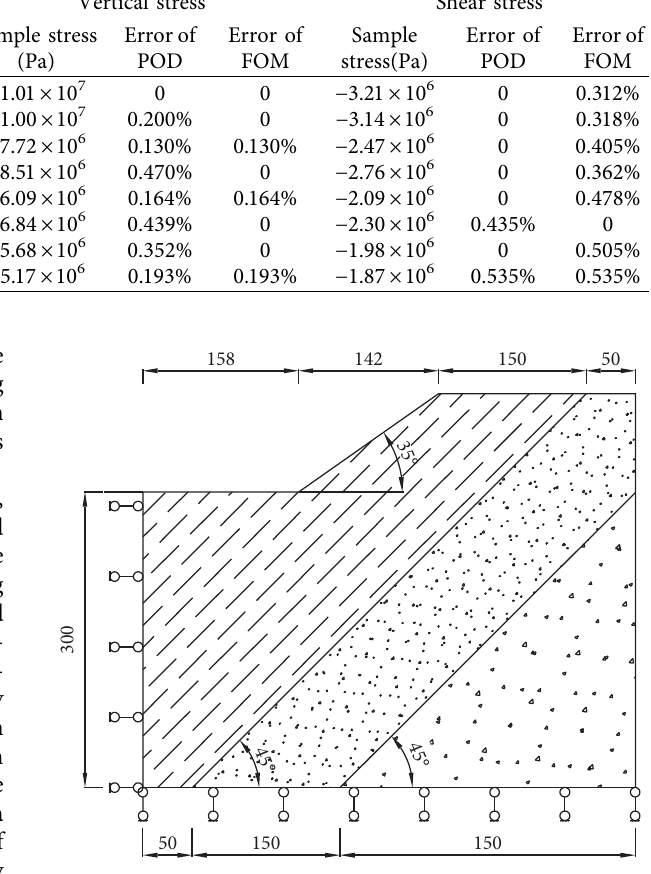
Figure 7: A slope with multiple stratums (unit: